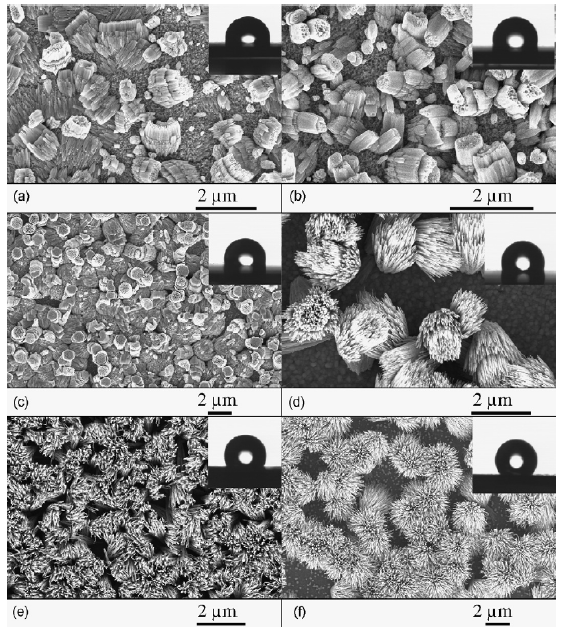
Figure 4. SEM images of ZnO nanostructures as a function of growth temperature (Tgr): ( a ) corals (Tgr = 200–240 ◦ C), ( b ) cabbages (Tgr = 240–280 ◦ C), ( c ) porous hexagons (Tgr = 280–320 ◦ C), ( d ) bun- dles (Tgr = 320–365 ◦ C), ( e ) sheaves (Tgr = 365–440 ◦ C) and ( f ) open sheaves (Tgr = 440–550 ◦ C). The insets show contact angle images from droplet experiments for the respective as-grown samples, which demonstrate size-dependent, tunable hydrophobicity. Figure reproduced with permission from [44]. Copyright (2012)